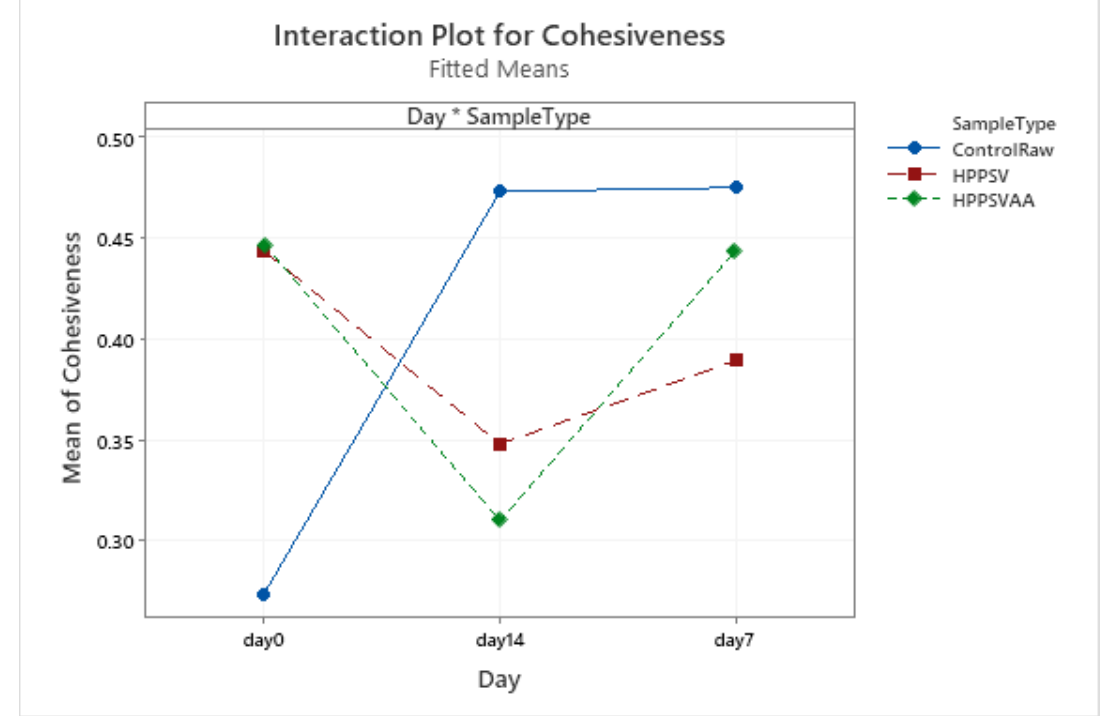
Figure A10. Effect of treatments and storage time on the springiness of hybrid patty (HPPSV: HPP- SVCOOK).